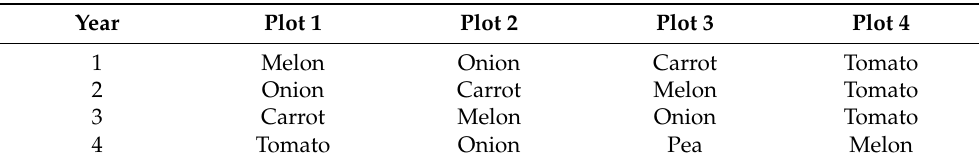
Table 3. Tomato rotation designed, wherein processing-tomato is cultivated in the same plot for three consecutive years.